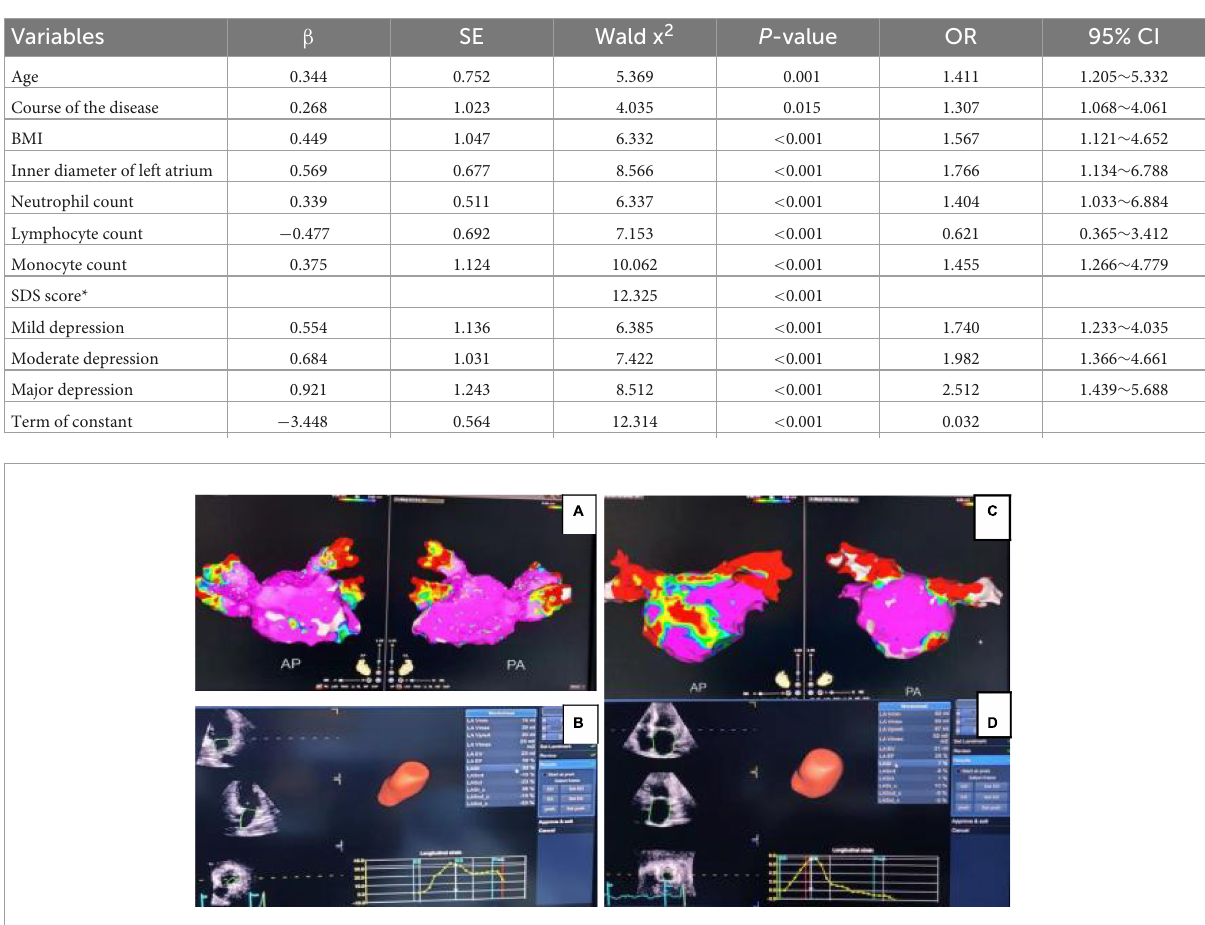
TABLE 4 Effect of SDS score and other indicators on recurrence 1 year after radio-frequency ablation.